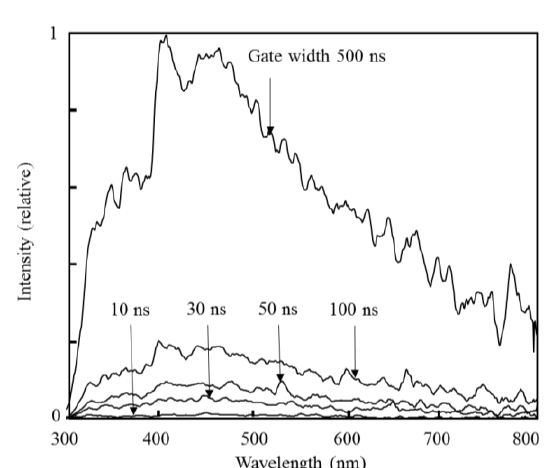
Fig. 2 Dependency of solar spectrum intensity on gate time-width.